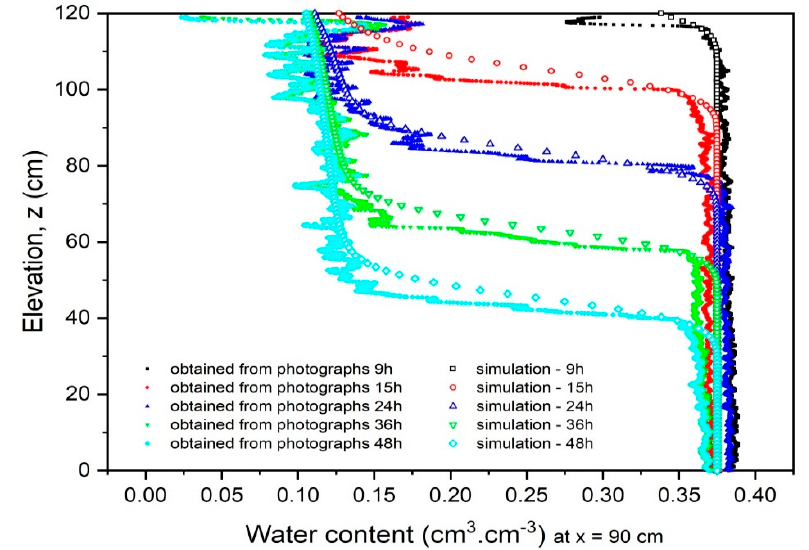
Figure 9. Water content profiles in the middle of the flow tank (x = 90 cm) simulated (open symbols) and obtained with photometric procedure (solid symbols) at different times of the first drainage–imbibition experiment (black squares = 9 h; red circles = 15 h; blue triangles = 24 h; green triangles = 36 h; cyan diamonds = 48 h).